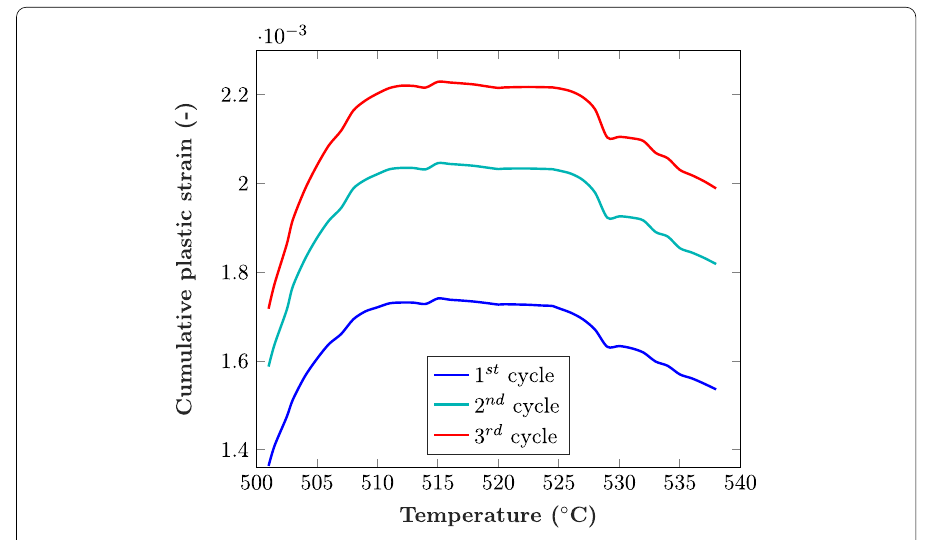
Fig. 4 Equivalent cumulative plastic strain at the end of each cycle according to temperature T on the most loaded element of the